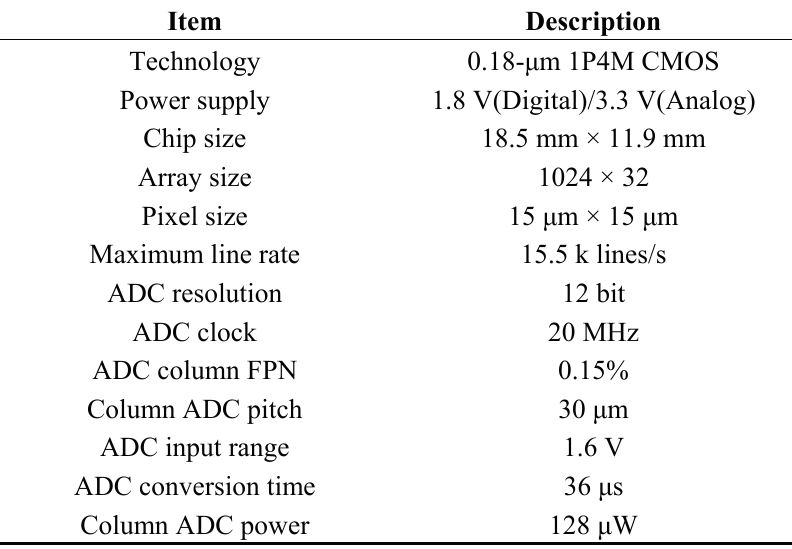
Table 2. Performance Summary.